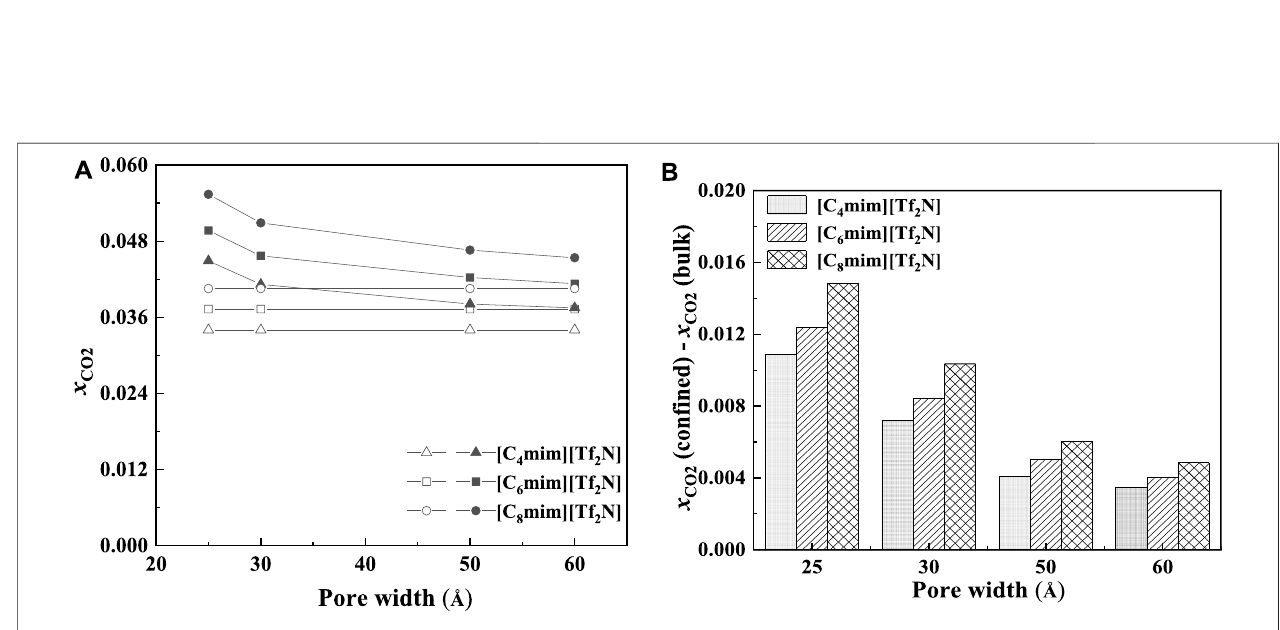
FIGURE 15 | Calculated CO 2 solubility (A) and additional solubilities (B) of ILs con fi ned in slit-shaped pore with different widths at 298.15 K and 1 bar. (A) Solid symbols, data for con fi ned ILs; open symbols, data for bulk ILs.